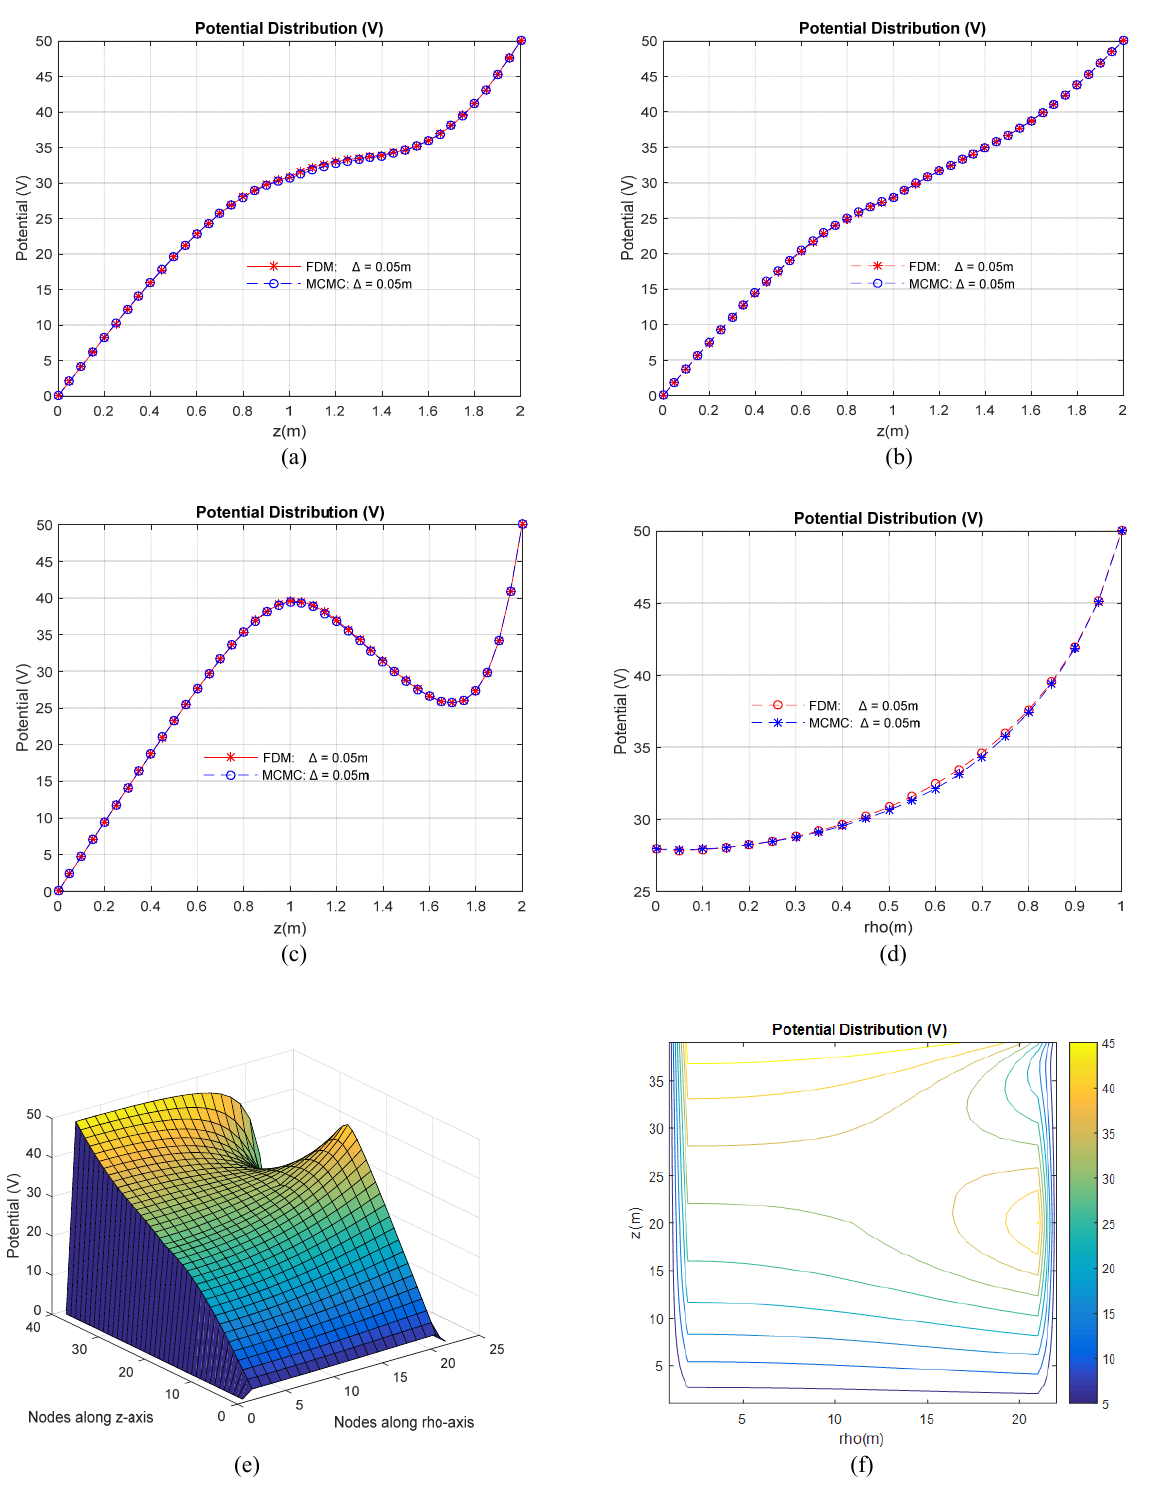
Figure 6. Potential Distribution along (a) m2z0m50  ,.  ; (b) m2z00  ,  (line of symmetry) (c) m2z0m90  ,.  (d) m101z   , (media interface), (e) Surface Plot (f) Contour Plot for Axisymmetric Inhomogeneous Problem with mixed boundary